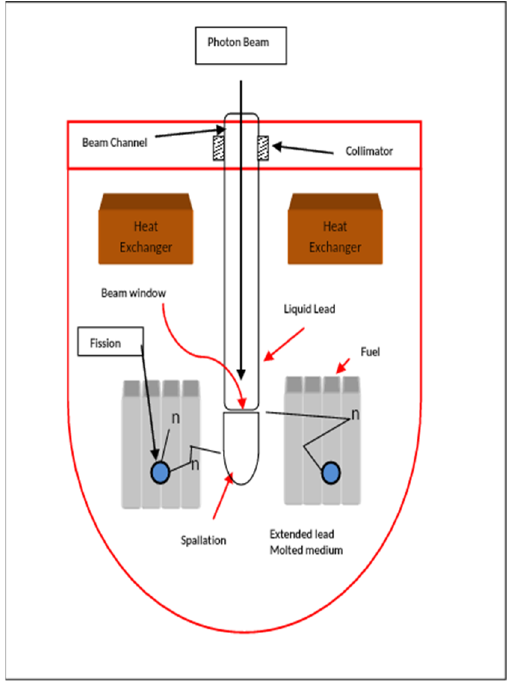
Figure 1. Schematic of ADS reactor